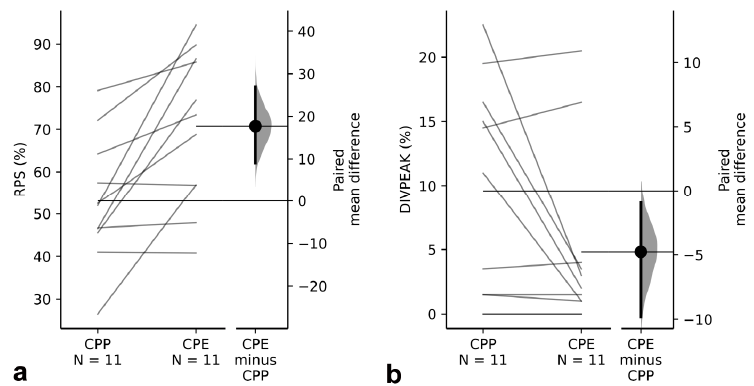
Figure 6. Between-subspecies paired comparison of RPS (homogenization index) and DIVPEAK (degeneration index) for the 11 orthologous pairs of TR families showing the NS pattern in CPP and B pattern in CPE. Note how these TRs show ( a ) higher homogenization (paired mean difference for RPS between CPP and CPE = 17.7 (95%CI: 9.1, 26.9)), and ( b ) lower degeneration (paired mean difference for DIVPEAK between CPP and CPE = − 4.77 (95%CI: − 9.82, − 0.955)) for the orthologous TRs displaying the B pattern in PPE.